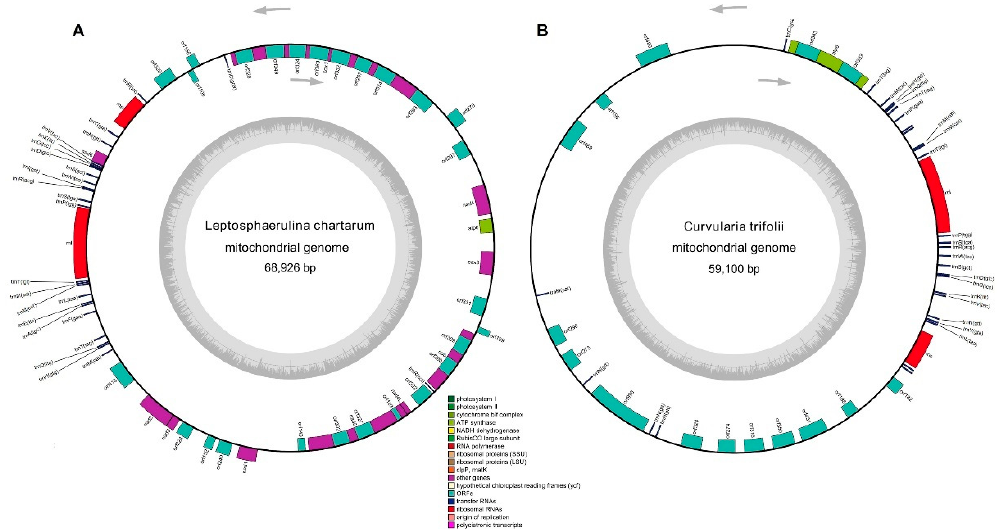
Figure 2. Circular mapping of the complete mitochondrial genome from ( A ) L. chartarum and ( B ) C. trifolii . The two mitogenomes were annotated using MFannot and were used to construct their graphical maps using OGDRAW (http://ogdraw.mpimp-golm.mpg.de/cgi-bin/ogdraw.pl).